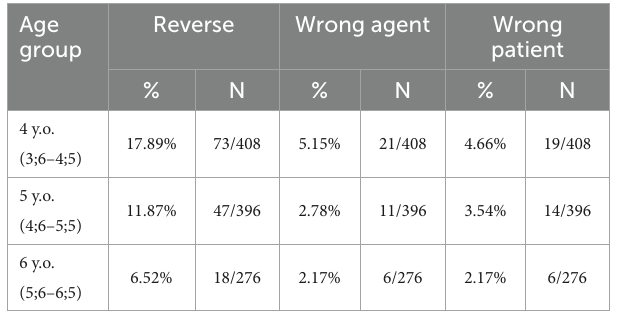
TABLE 4 Percentages (%) and counts ( N ) of errors in comprehension of ba-construction. Age Reverse Wrong agent Wrong group